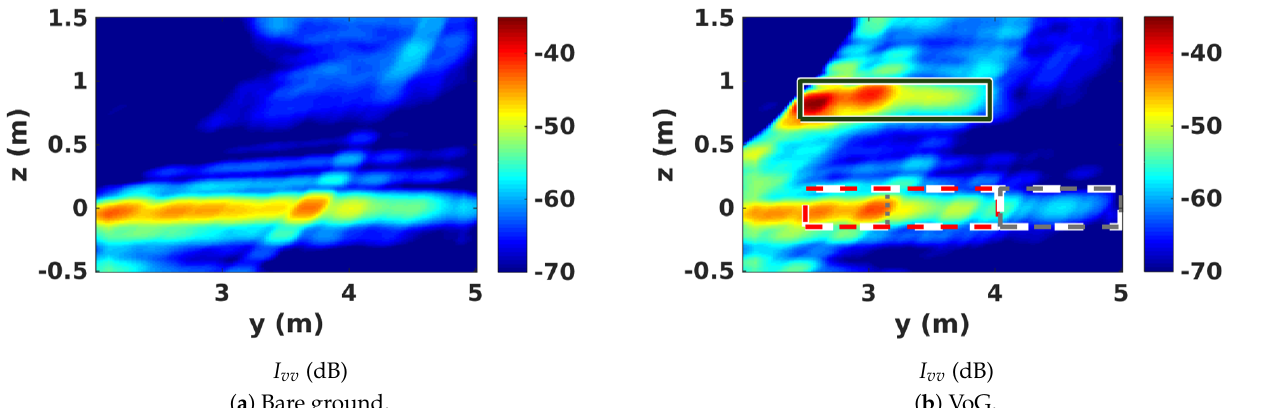
Figure 14. Tomographic profiles of bare ground and VoG in Lexicographic basis.